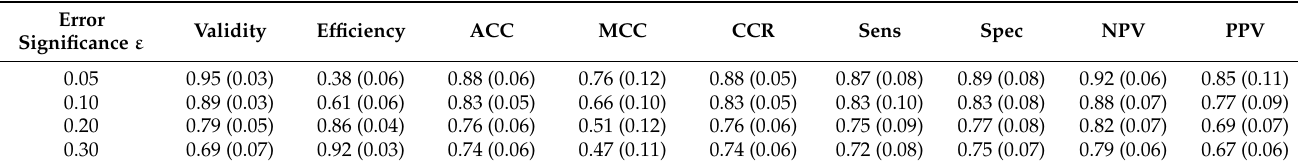
Figure 2. Mean performance of 10-fold CV as a function of the number of bioactivity descriptors selected for model building at the significance level ( A ) ε = 0.05, ( B ) ε = 0.10, ( C ) ε = 0.20, ( D ) ε = 0.30. The horizontal, dashed line indicates the validity expected from the selected significance level ε ; the vertical, dashed line marks the performance of models trained on 10 descriptors. Table 1. Ten-fold CV Performance of Models Based on 10 Bioactivity Descriptors 1 .